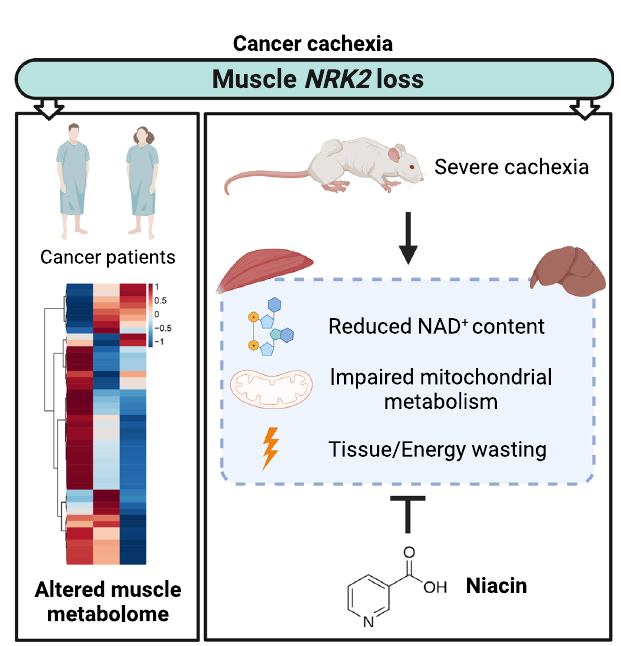
Fig.6|Graphicalrepresentationofthemain fi ndingsofthisstudy. Observations in cancer patients con fi rm the data obtained in three distinct murine models of experimental cancer cachexia and are supported by positive results in the inter- vention study involving severe (C26-F) and chronic (VCM) cancer cachexia. The bene fi cialeffectsproducedbyniacinonNAD + content,mitochondrialhomeostasis and energy metabolism are generalized despite model speci fi c alterations are